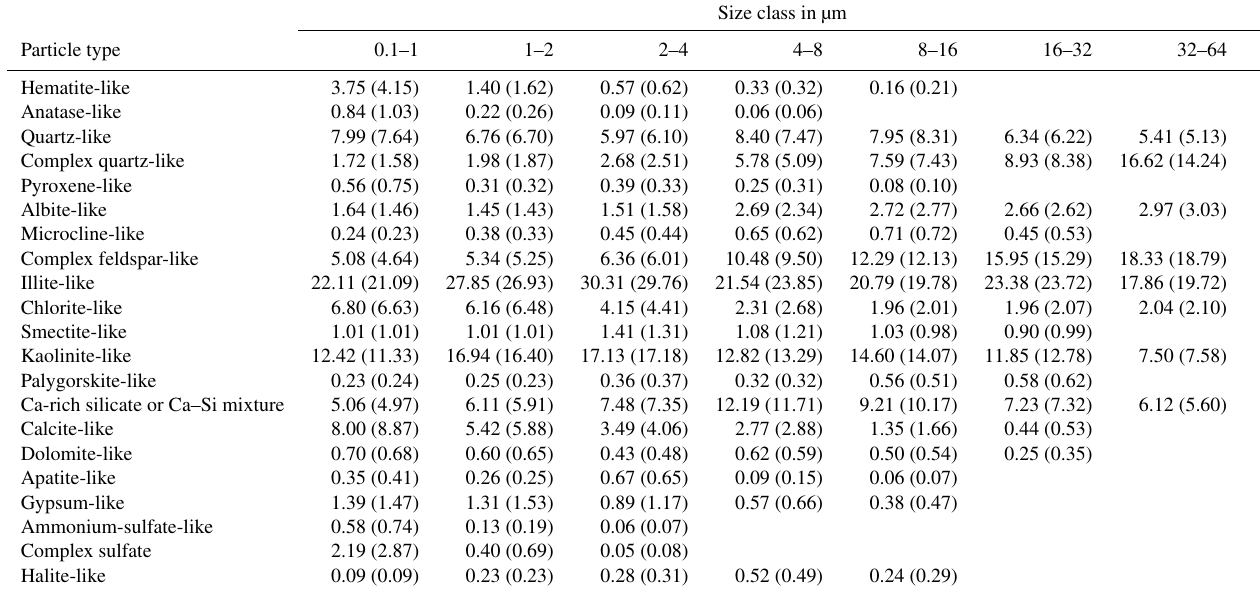
Table 1. Size-resolved mass fraction (%) of particles in each particle class (number fraction in parentheses).